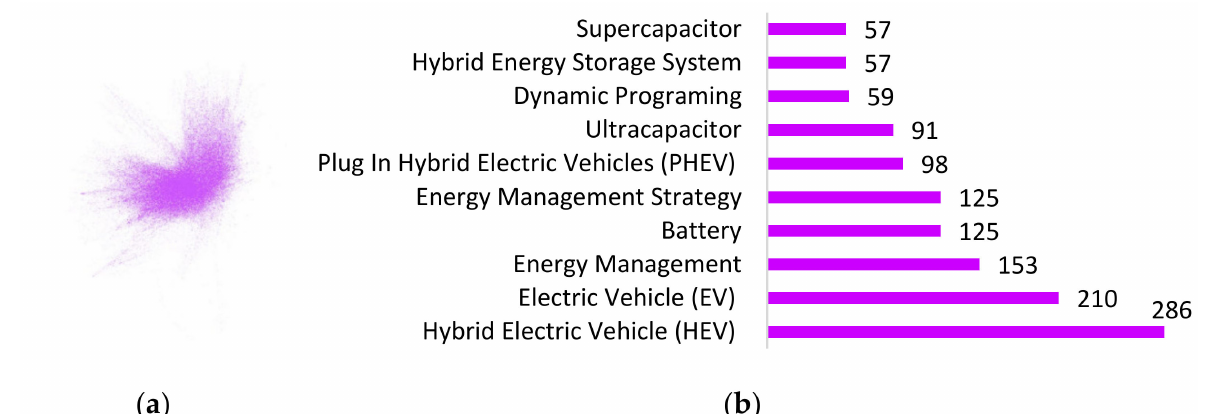
Figure 11. Representation of the HEV control strategies community: ( a ) isolated distribution of publications; ( b )